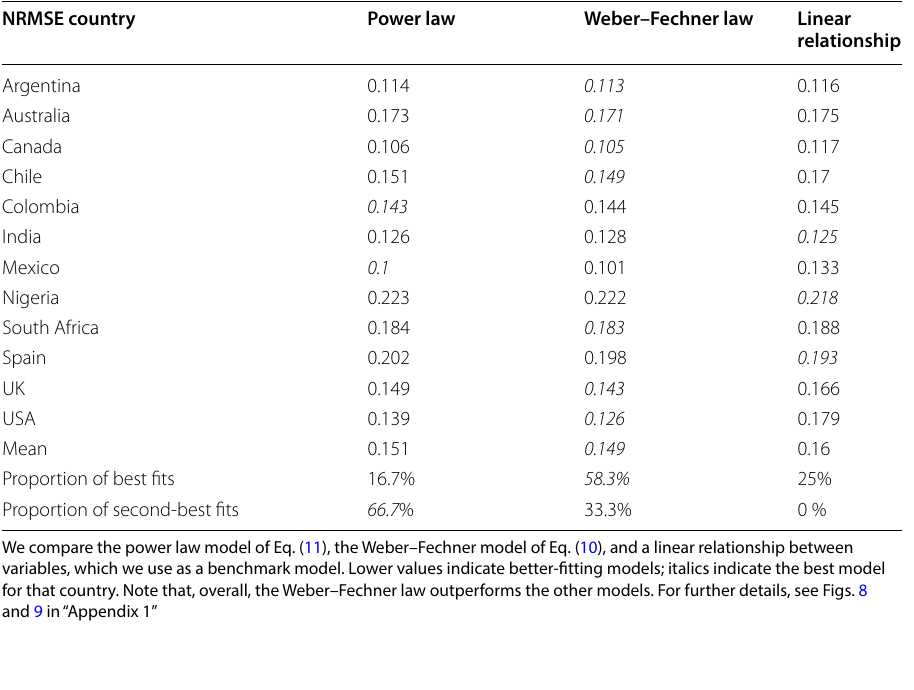
Table 5 Comparison of the normalised root mean squared error (NRMSE) [see Eq. (12)] between the models of attention